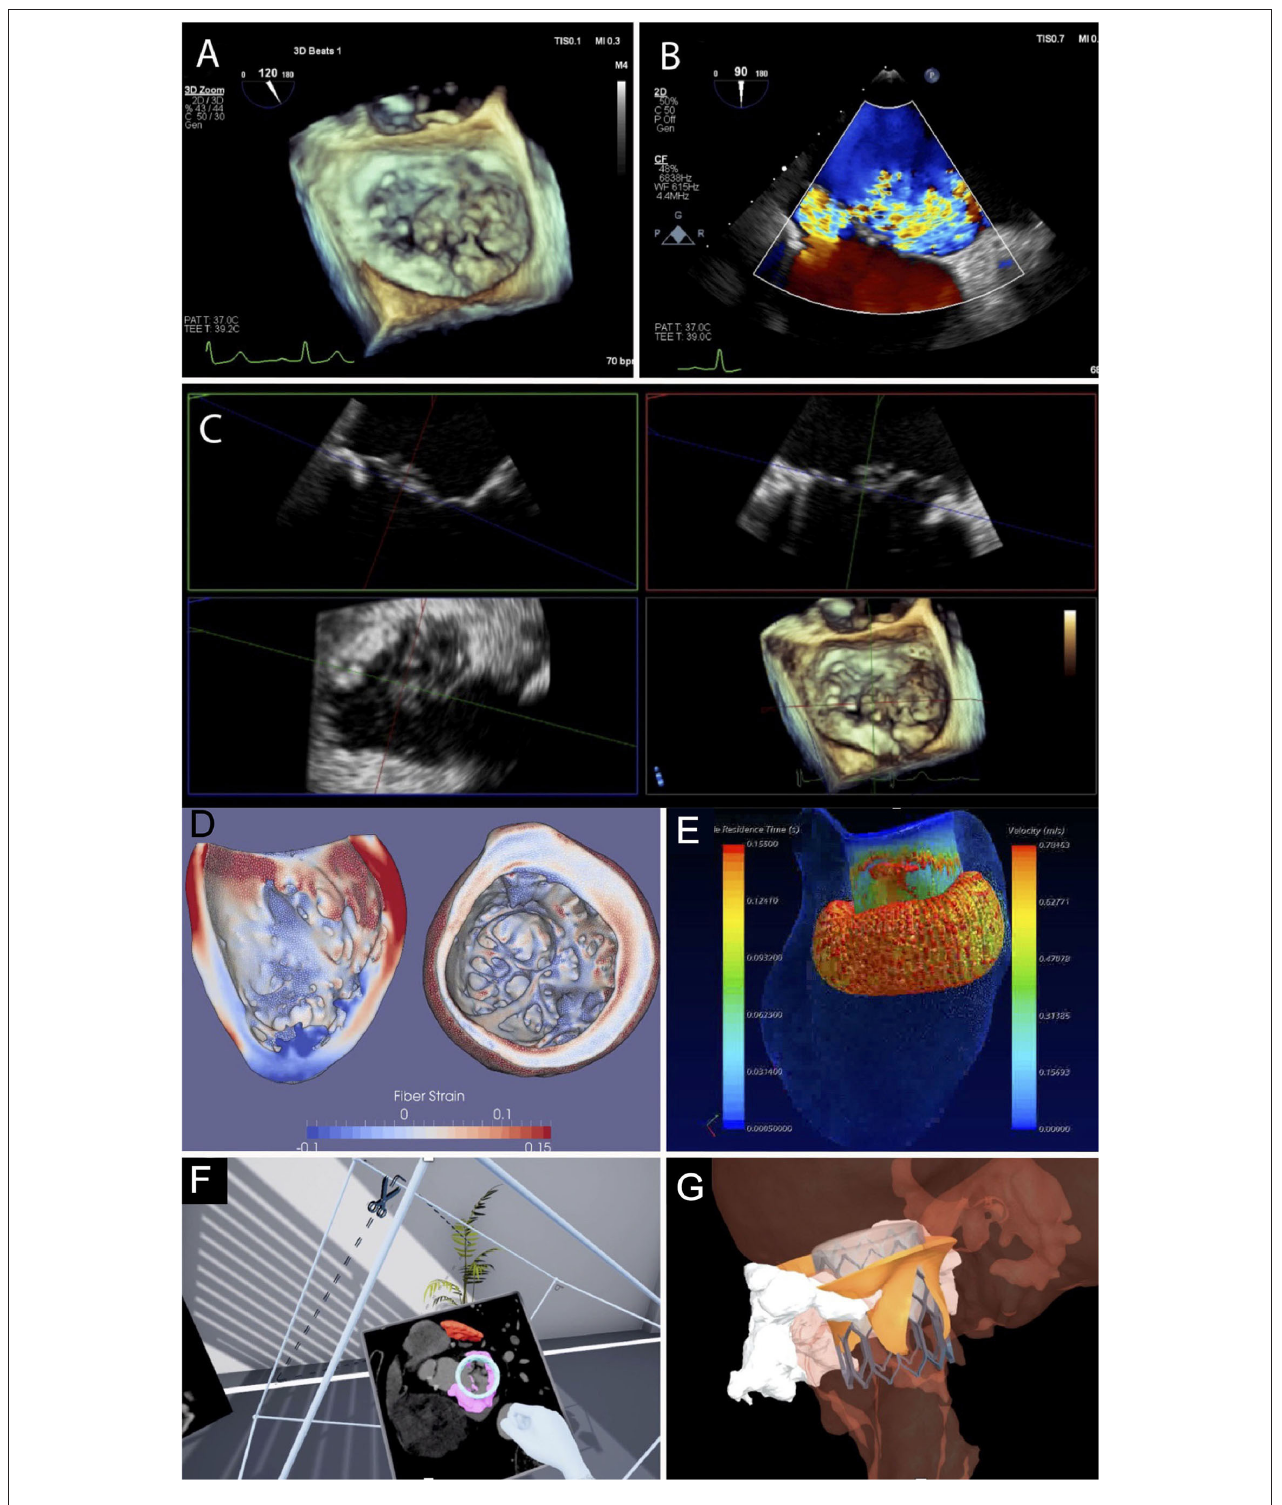
FIGURE 1 | Transoesophageal echocardiogram for edge-edge mitral valve leaflet repair. (A) Shows 3D imaging, (B) Demonstrates Doppler and (C) Dual plane imaging. Advanced imaging processing techniques used within the TMVC. (D) Shows myocardial fiber strain from CT. (E) Demonstrates 4D CT flow to predict blood residence time within the left ventricle following TMVR device deployment. (F) Is an example of virtual reality. (G) Demonstrates virtual implantation and modeling. 3D, 3-dimensional; TMVC, transcatheter mitral valve clinic; CT, computed tomography; TMVR, transcatheter mitral valve replacement.